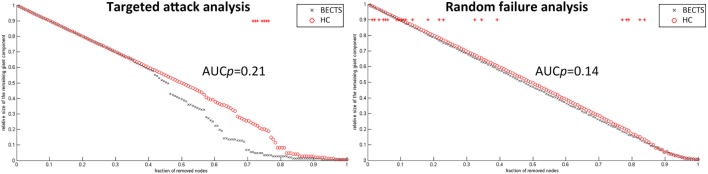
Random and targeted attack analysis. Alterations in the size of the largest preserving component of the network are shown as a function of a fraction of randomly (left panel) and targetedly (right panel) removed nodes. In many proportions of the deleted nodes and the area under the curve (AUC) results, there was no significant difference between the two groups (p > 0.05) of the resilience of the networks to both targeted and random attacks. In general, network of BECTS showed less robust to the targeted attack as compared with the controls, but the statistical significance only appears at a few fractions of deleted nodes (p < 0.05, the red star indicates a significant difference across different network densities between the two groups).